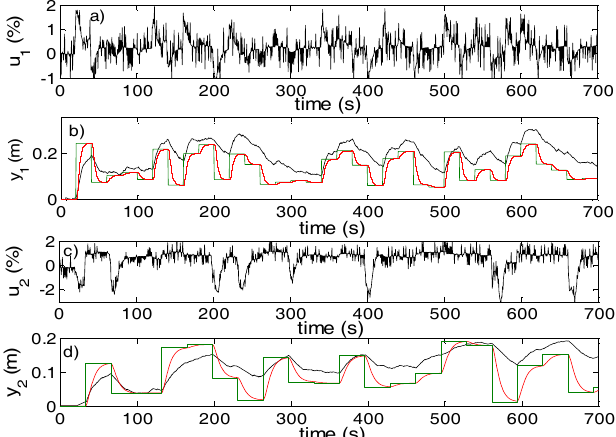
Figure 5. Typical training and learning episode. The perturbed control (black), the reference inputs to the CS (green) and the RM outputs (red).